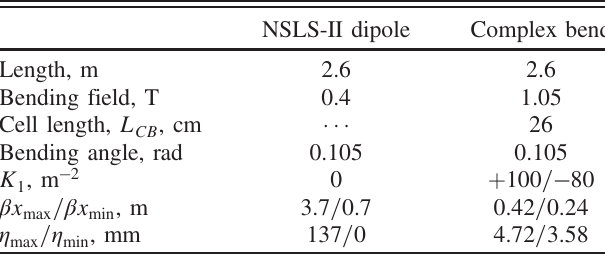
FIG. 4. Cartoon illustrating the concept of the complex bend.